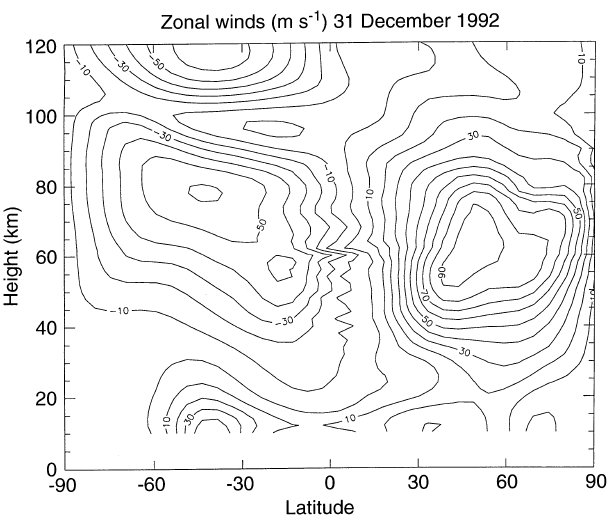
Fig. 3. Zonally averaged zonal winds at solar maximum for 31st December, 1992 from the EMM